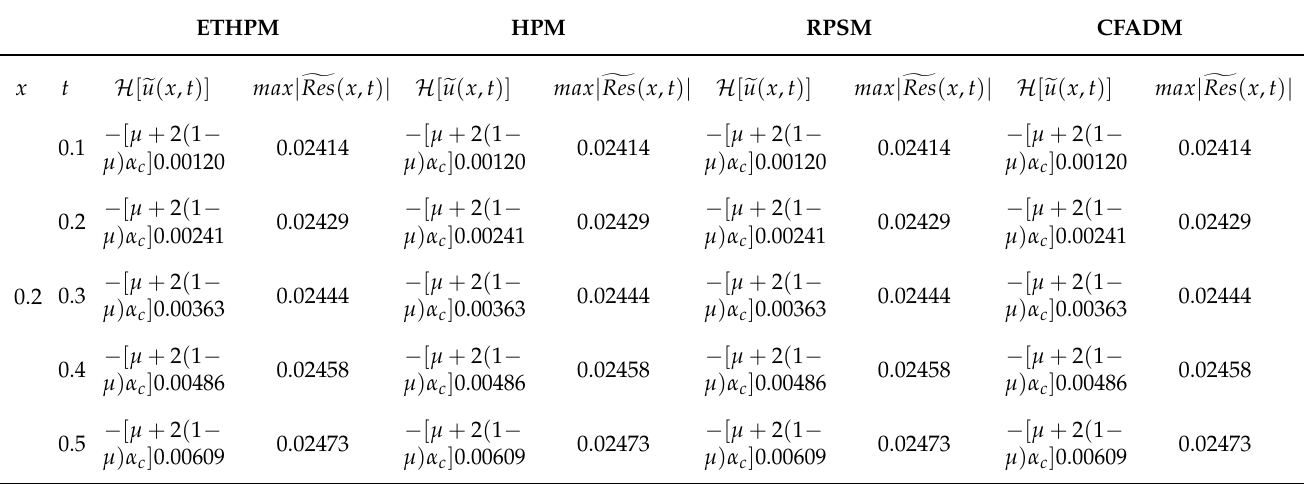
Table 6. H [ (cid:101) u ( x , t )] and max | (cid:103) Res ( x , t ) | by ETHPM, HPM, RPSM, CFADM for α =